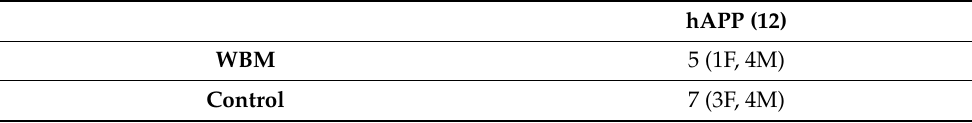
Table 3. Number of Mice used in Congo